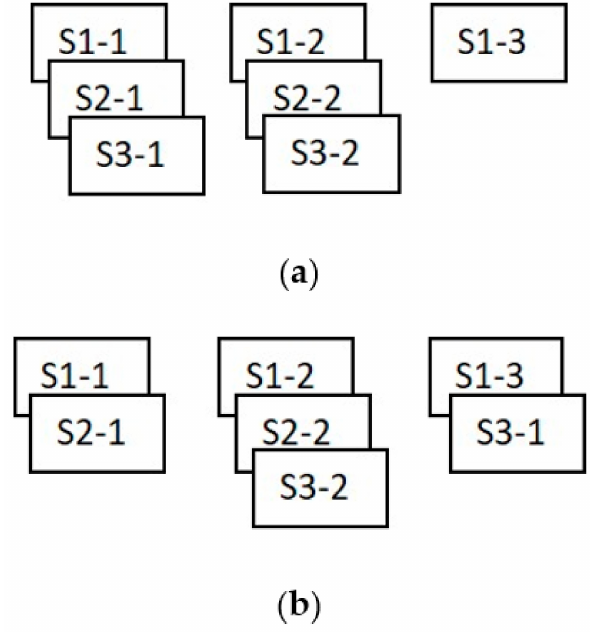
Figure 1. ( a ) A class scheduling that meets constraints (7a) and (7b) but produces an unbalanced number of students in subject s 1. Only few students are allowed to register in s 1-1 and s 1-2. ( b ) A more balanced scheduling is obtained when constraints (7c) are